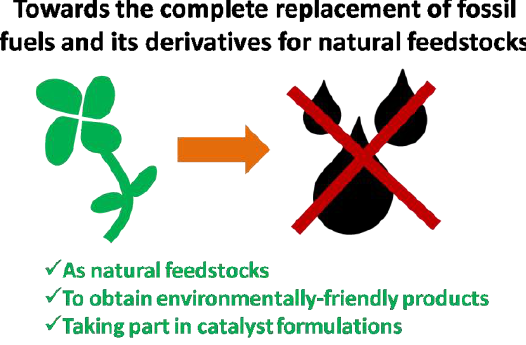
Figure 1. Main prospects for the implementation of green technologies.